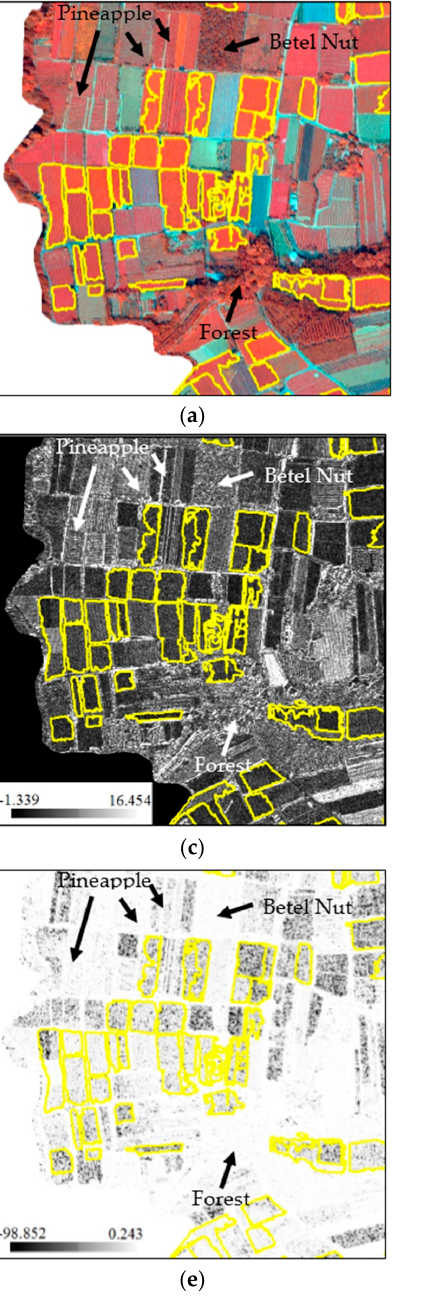
Figure 8. Signature comparison of tea, betel nut, pineapple and forest fields using input variables with higher B coefficient. ( a ) is the original image displayed with band 7, 3 and 2; while ( b – f ) are standardized CONTRAST6, DISSIMI6, HOMO2, CORREL6 and PC2 respectively. The yellow boundaries delineate the tea crop fields.